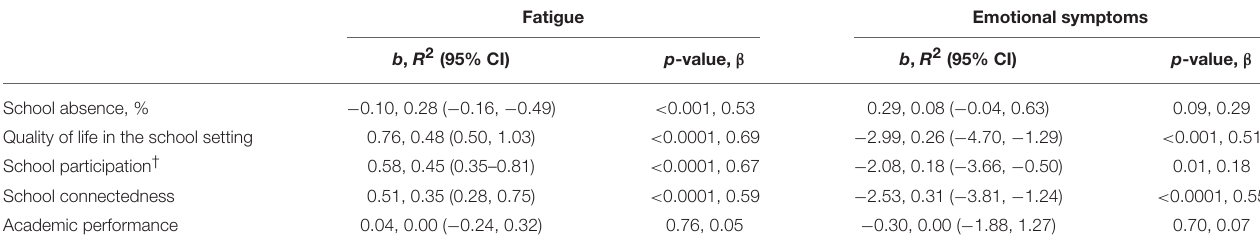
CFS, chronic fatigue syndrome. † N CFS =